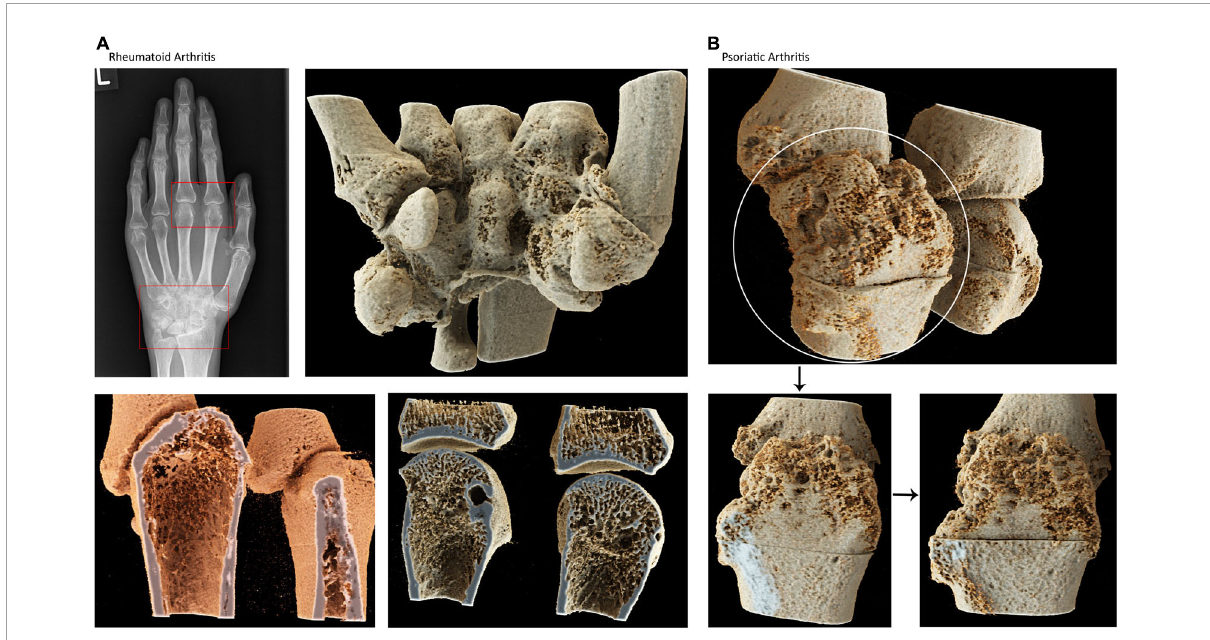
FIGURE3 Cinematic rendering of the hand joints in rheumatoid and psoriatic arthritis. (A) Conventional radiographs of the hand of a patient with rheumatoid arthritis showing carpal and metacarophalangeal pathologies. Cinematic rendering based on high-resolution CT images showing (B) carpal bones with deformities and erosions (upper row) peripheral, trabecular demineralization and erosive changes in RA. This technique enables photorealistic depiction of the inner life of the human bone (B) cinematic rendering based on high-resolution CT images showing bone erosion and new bone formation in psoriatic arthritis self-explaining the difference between RA and